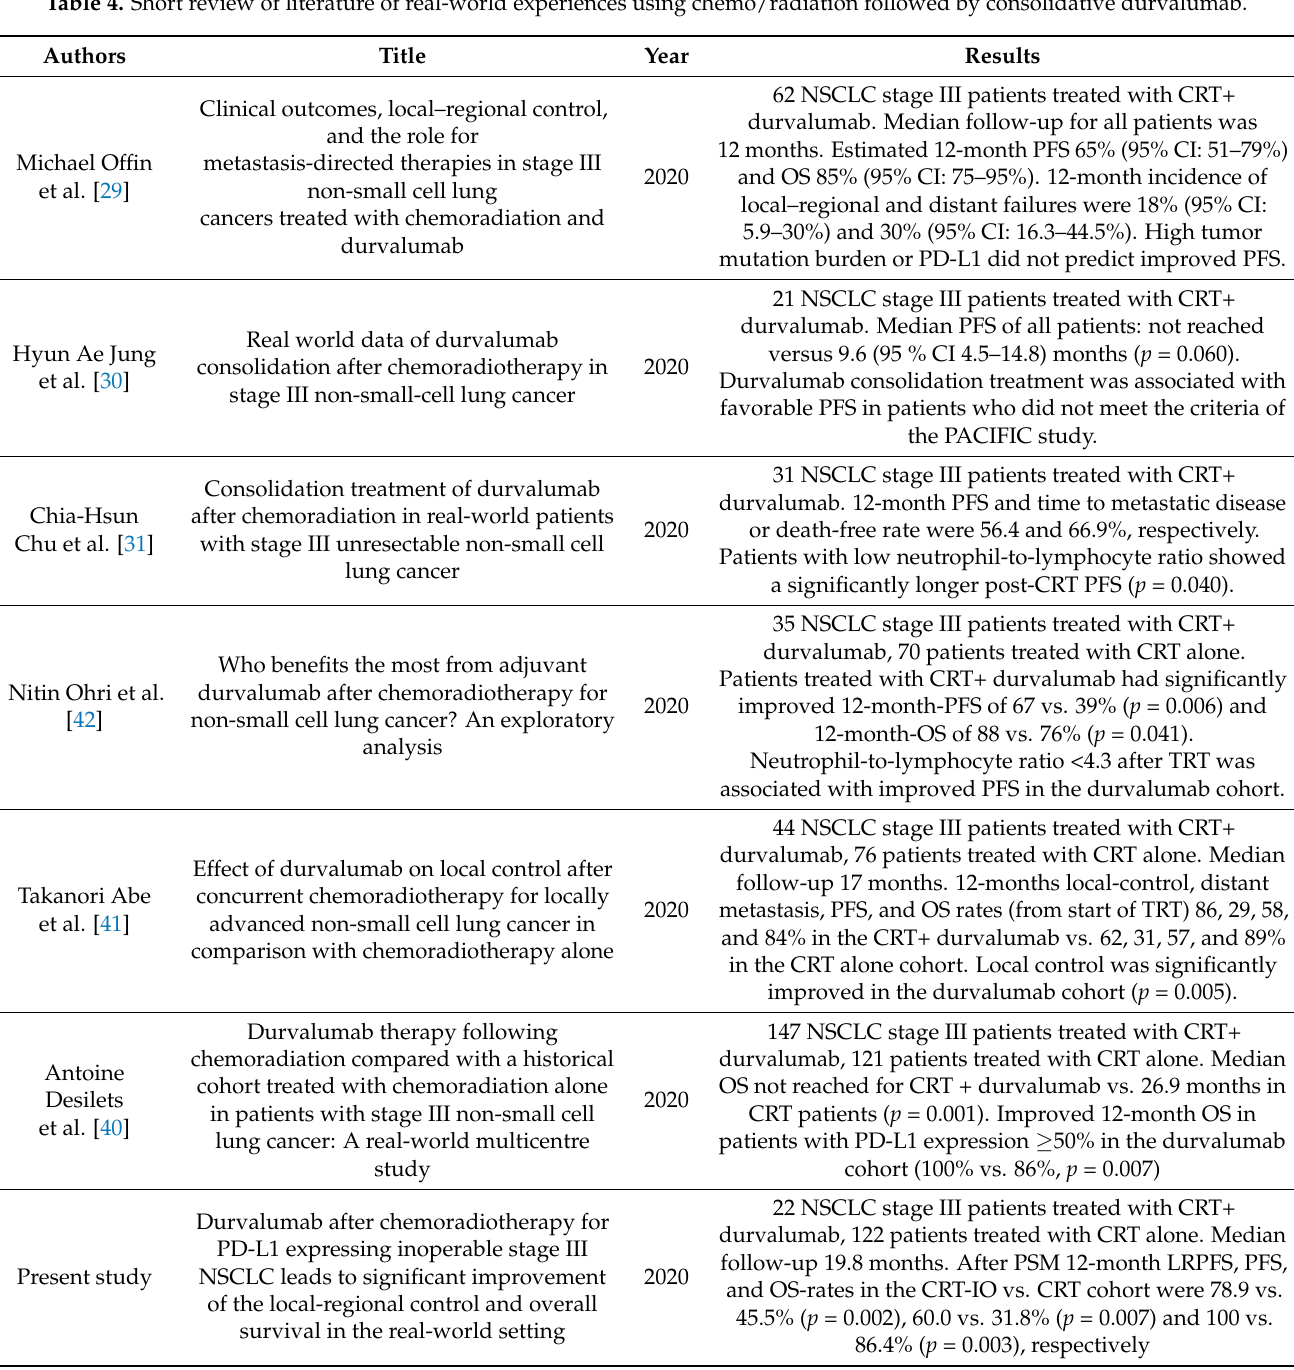
Table 4. Short review of literature of real-world experiences using chemo/radiation followed by consolidative